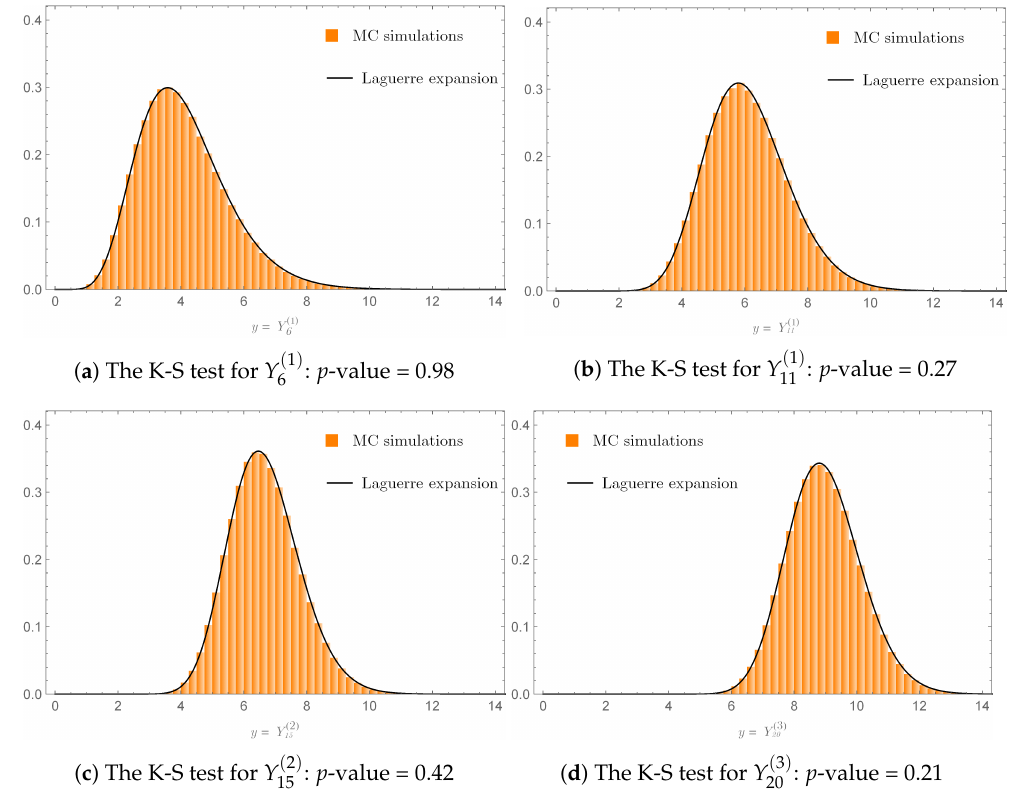
( j ) ( j ) ( j ) , ν , and δ are displayed in Figure 1a–d. i i i